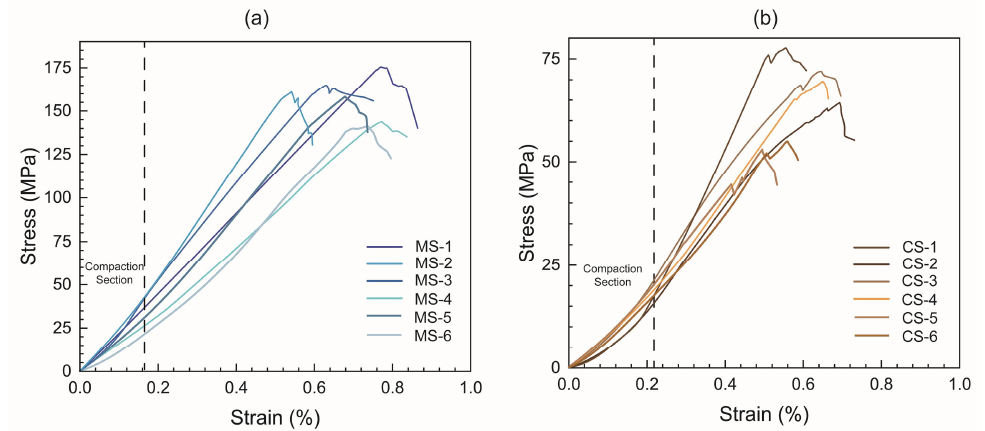
Figure 11. The uniaxial compressive strength of marine shale ( a ) and continental shale ( b ).